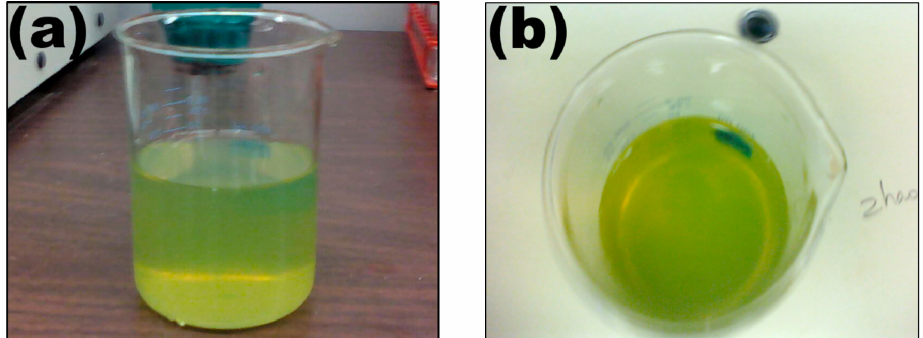
Figure 3. Natural organic matter (NOM) solutions extracted from RBS9 and RBS14 sediments ( a ) side view ( b ) top view.